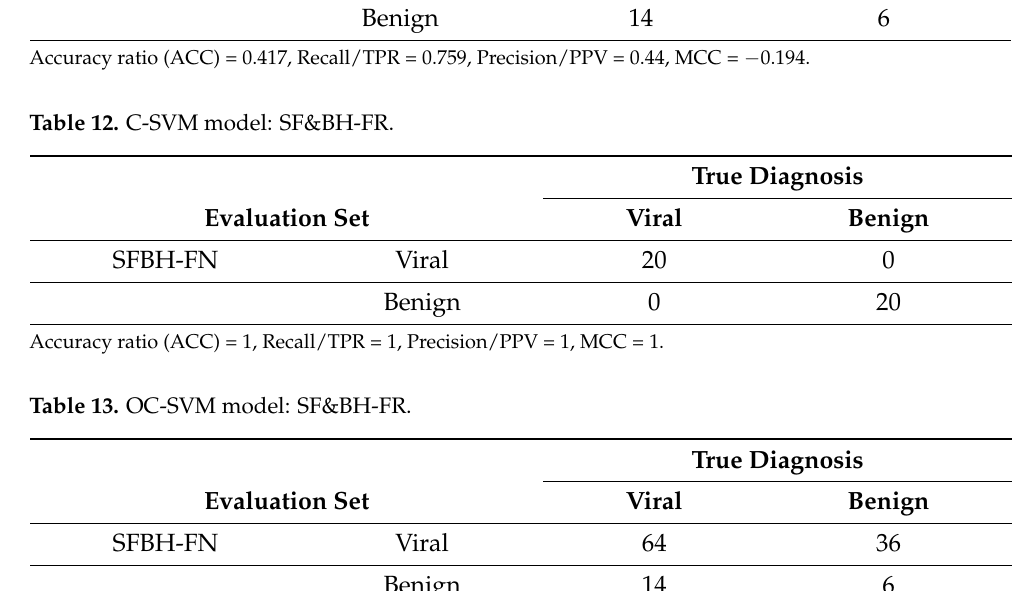
Table 11. OC-SVM model: SF-BN. True Diagnosis Evaluation Set Viral Benign SF-BN Viral 44 56 Benign 14 6